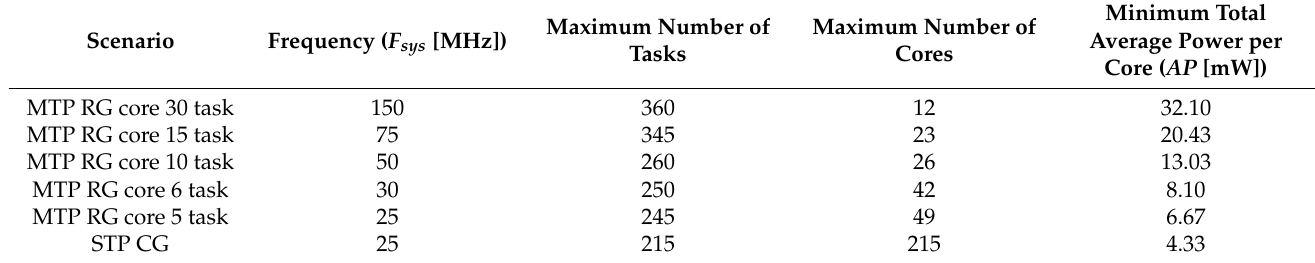
Table 4. Results obtained for different systems with the same productivity: SP =